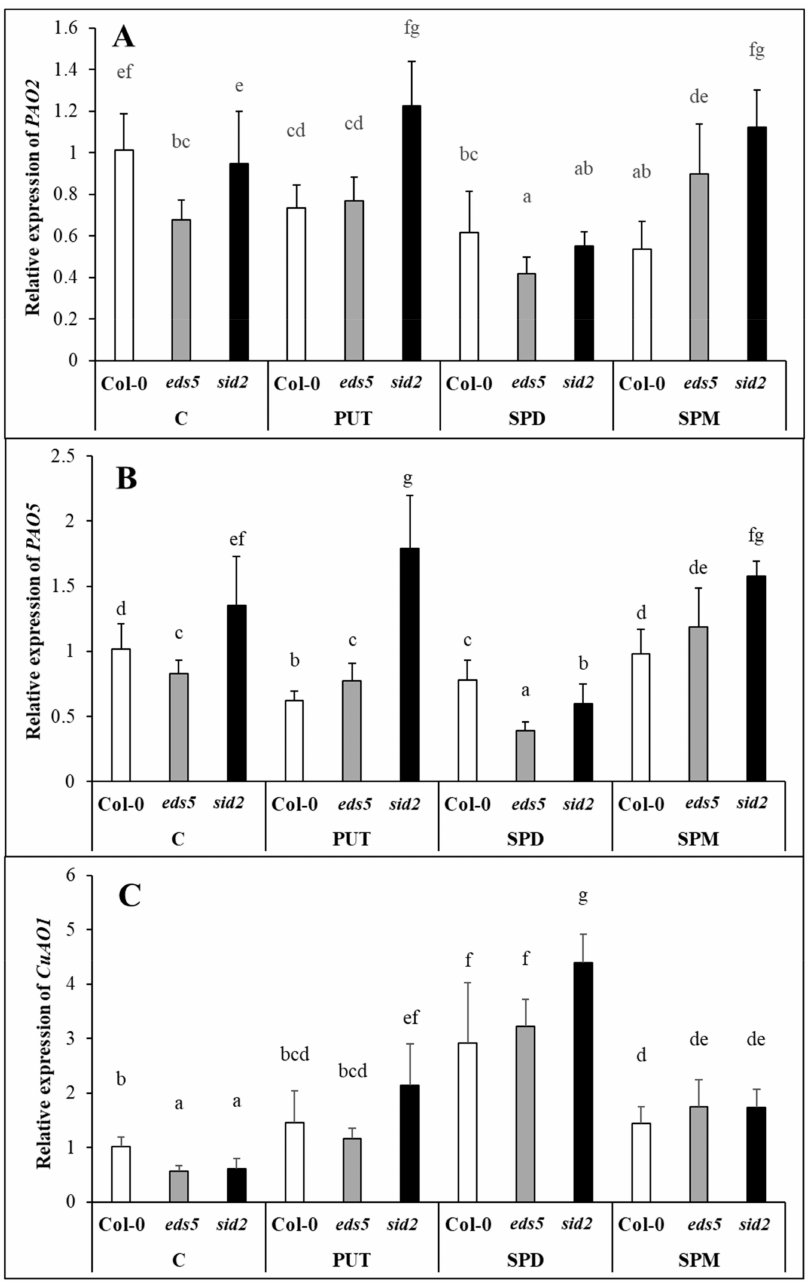
Figure 5. E ff ect of 0.5 mM 1-day of putrescine (PUT), spermidine (SPD) and spermine (SPM) treatments on the expression levels of polyamine metabolism genes ( A , B ) PAO2-5 : polyamine oxidase2-5, ( C ) CuAO1 : cooperamine-oxidase1)inCol-0, wildtype, eds5-1 ( eds5 )and sid2-2 ( sid2 ) Arabidopsis mutants. Data represent mean values ± SD. Di ff erent letters indicate significant di ff erences at p ≤ 0.05